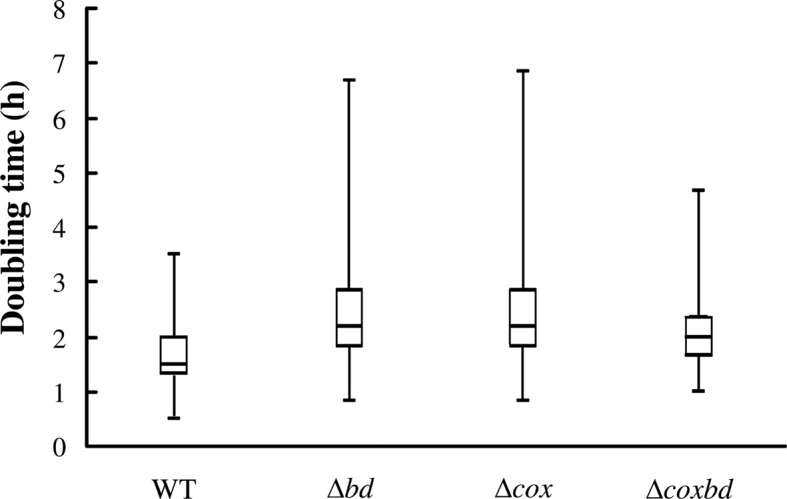
Variability of the second doubling time for the four strains after oxygen exposure.Box and whiskers plot representing the variability in the distribution of the second doubling time of the various DvH strains cultured with constant 0.02% O2 gas mixture sparging followed by a switch to anaerobic condition. These distribution patterns arose from at least 2 independent cultures (> 200 cells each).